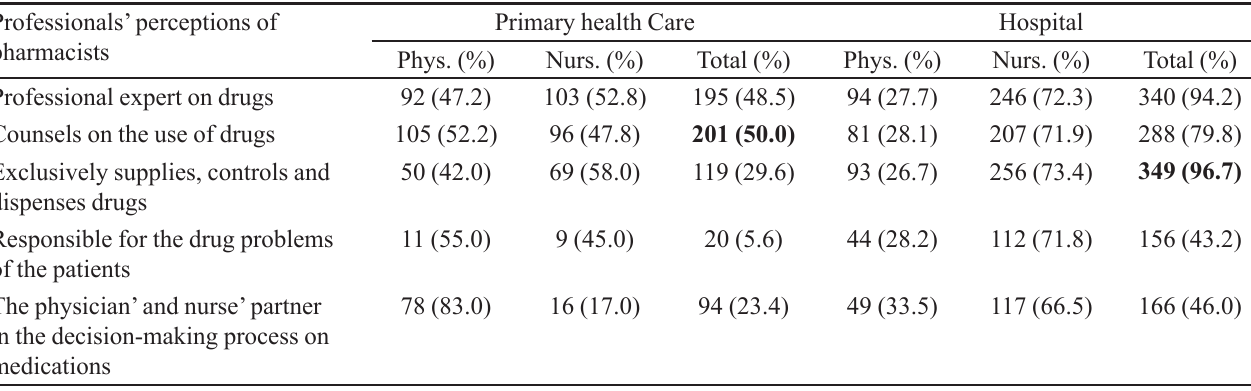
TABLE III - Professional’s perceptions of pharmacists’s role Professionals’ perceptions of